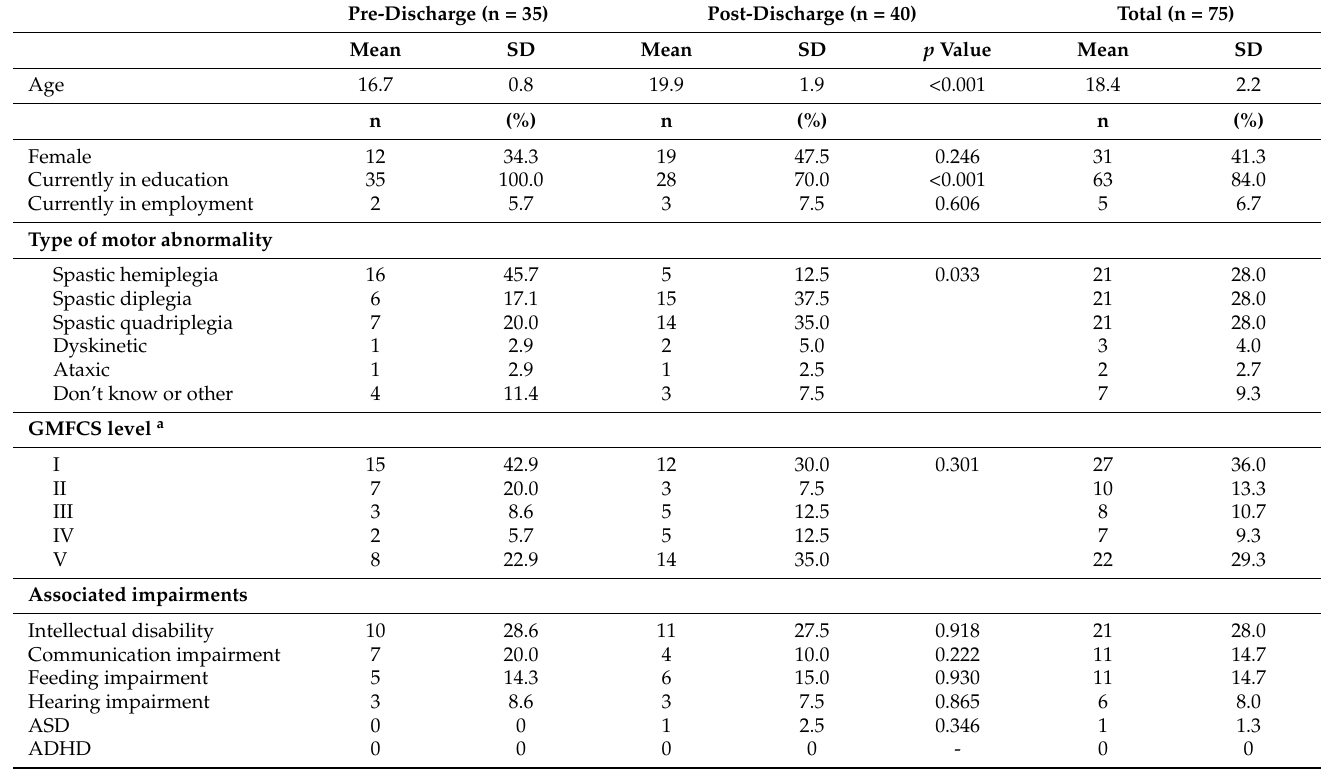
Table 1. Description of young adults.